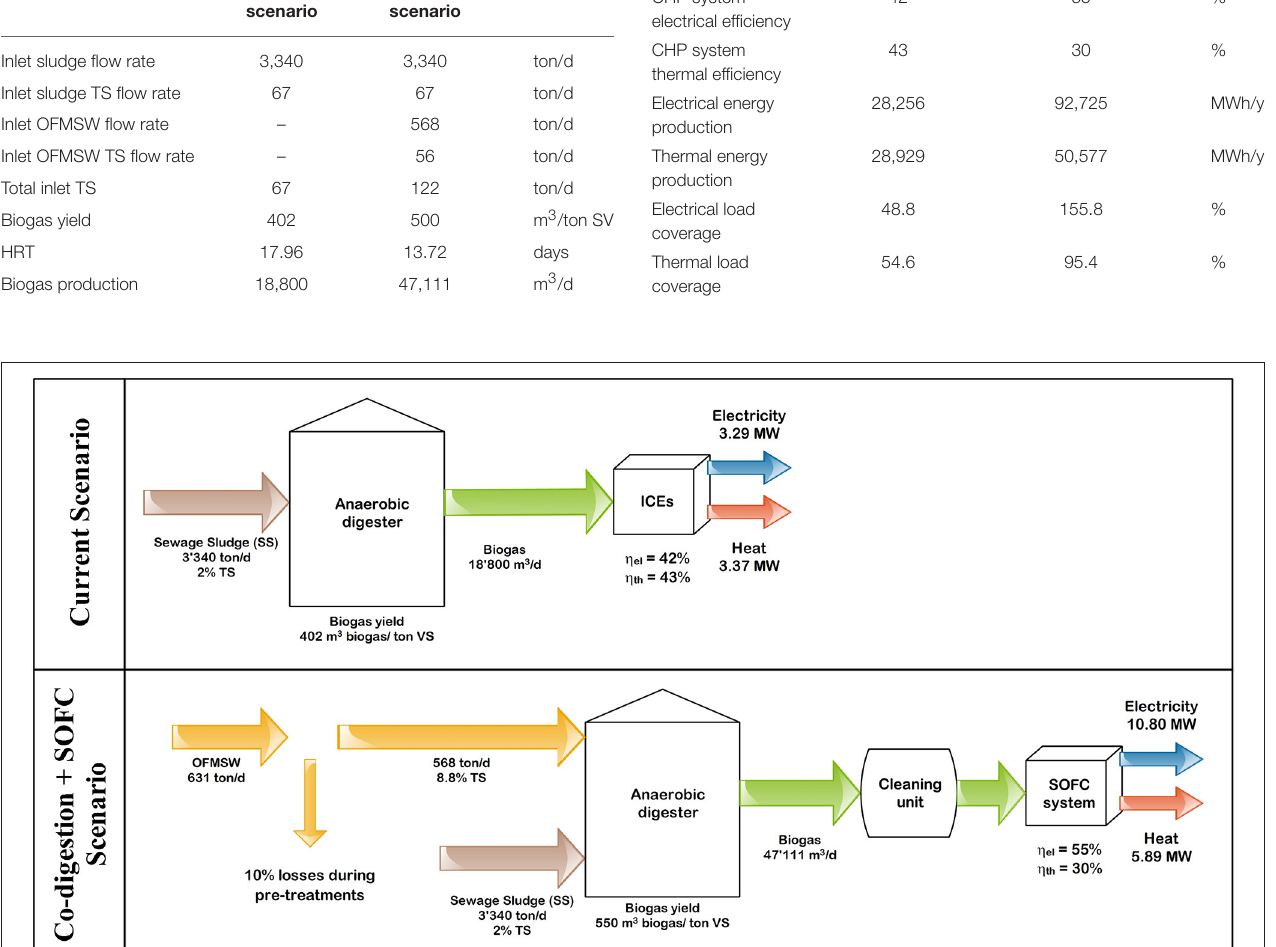
FIGURE 7 | Comparison of current and proposed scenarios: energy and mass